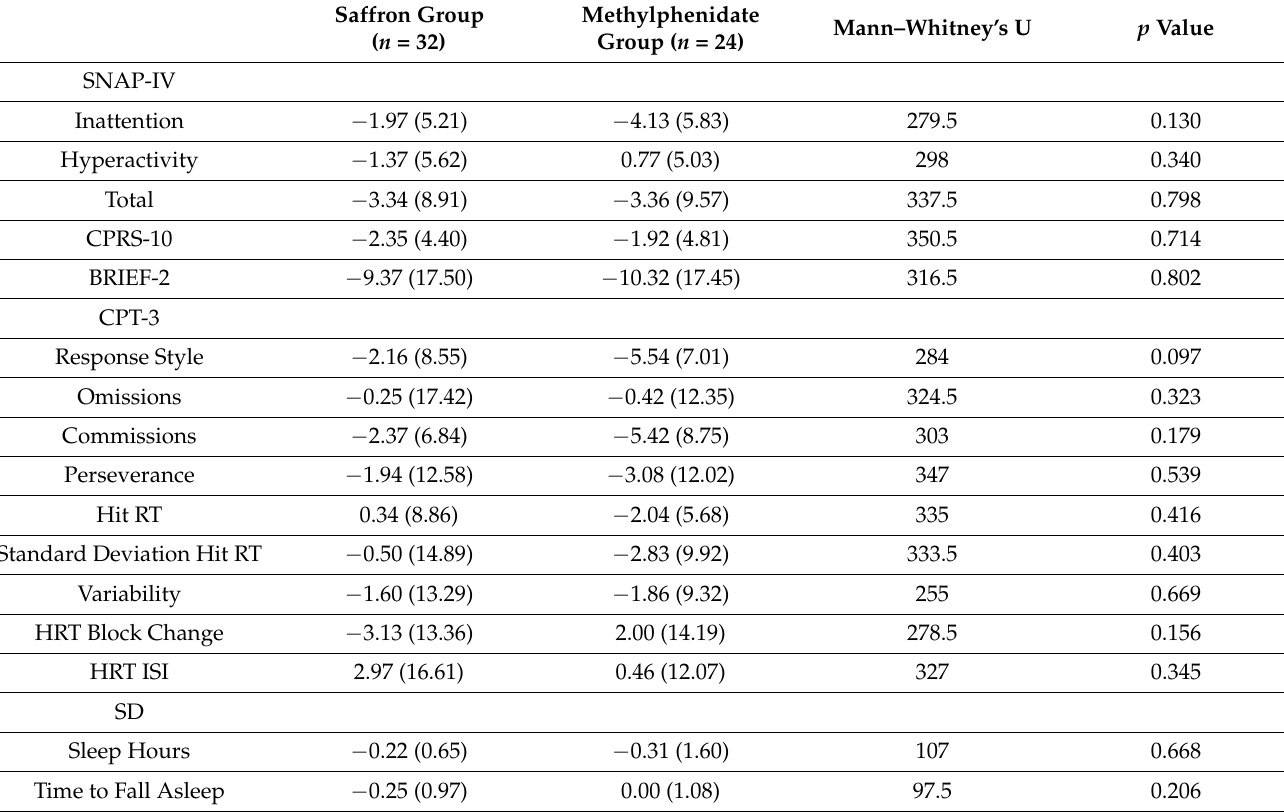
Table 4. Post-treatment